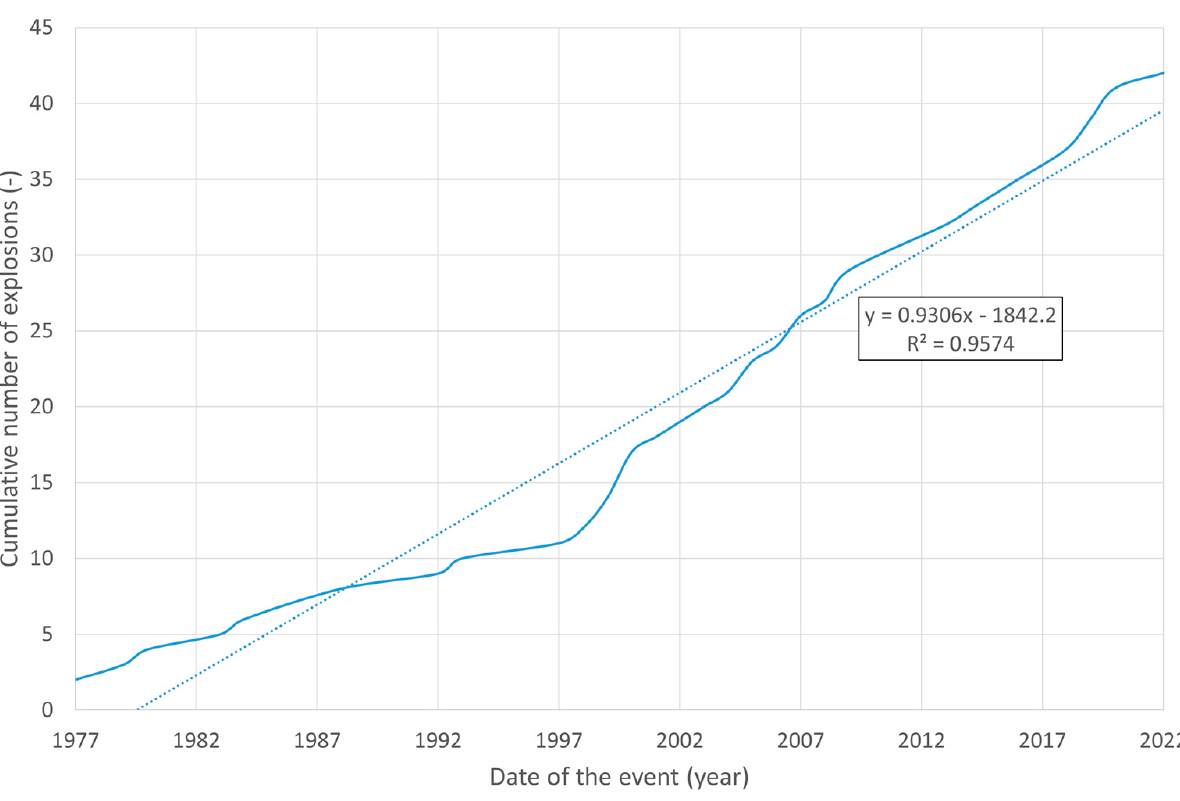
Figure 7. Cumulative number of explosions of marine main engine turbochargers in individual years for the period 1977–2022.